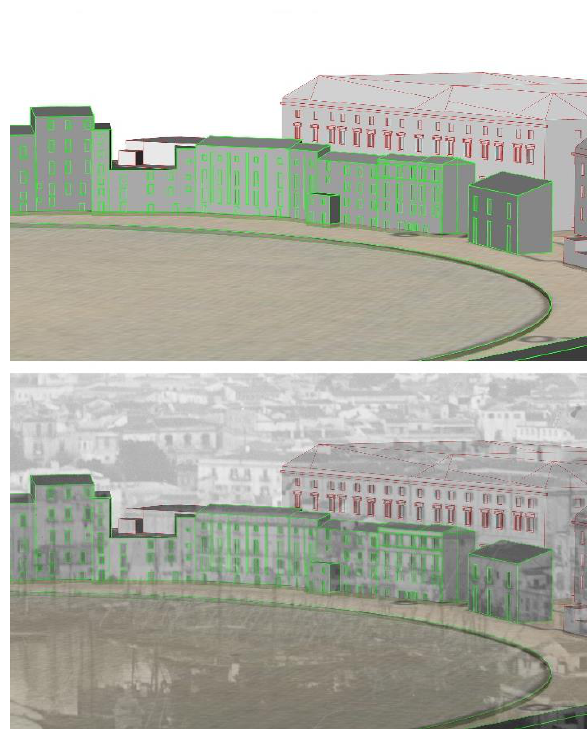
Figure 7: The reconstruction process.